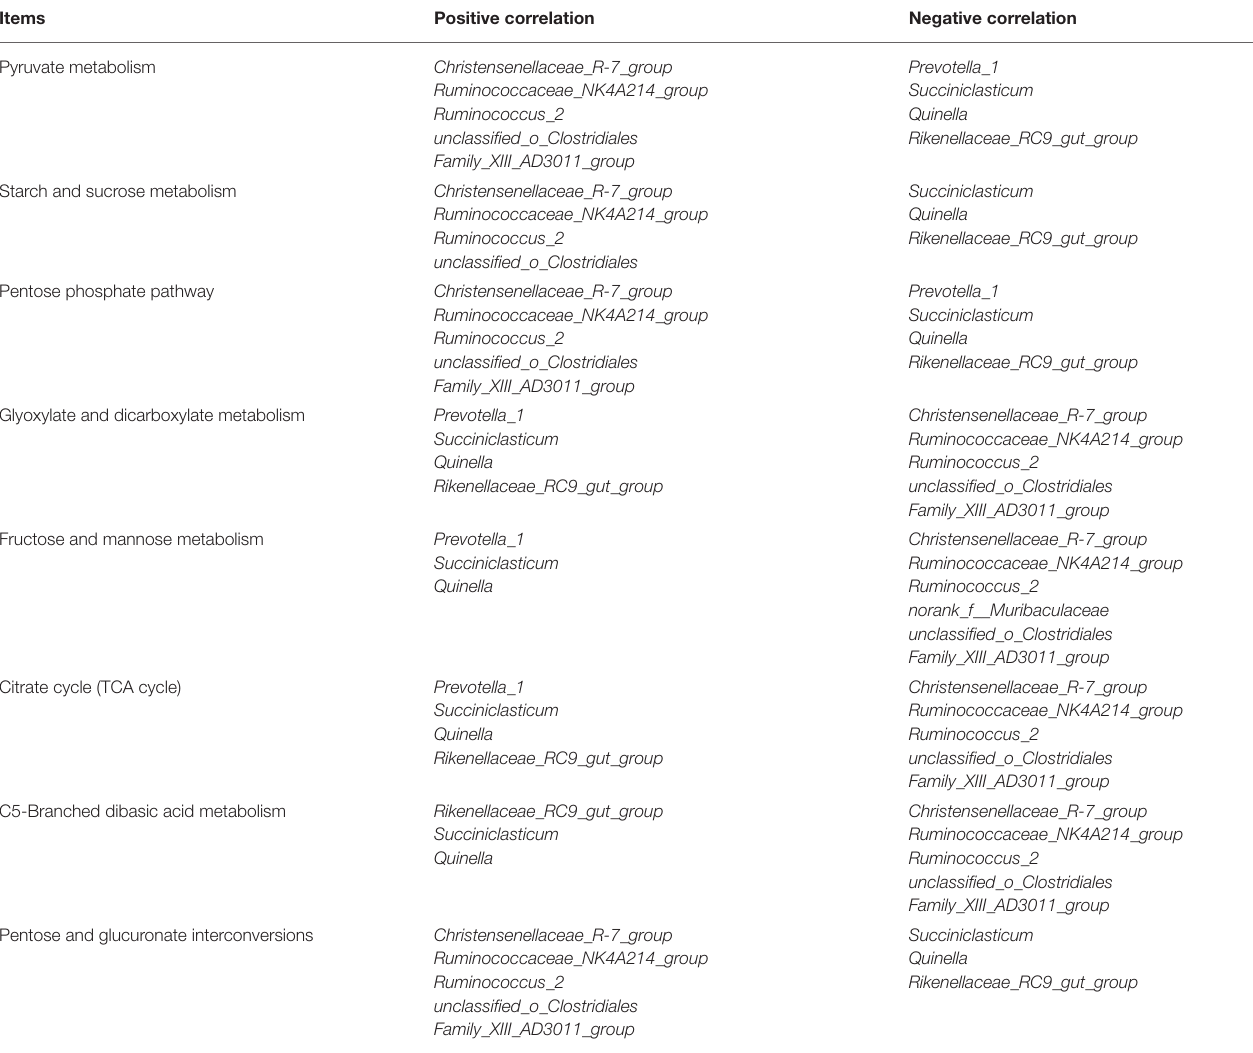
TABLE 7 | Significantly positive and negative correlations between the 10 most relatively abundant bacterial genera and altered carbohydrate metabolic pathway.